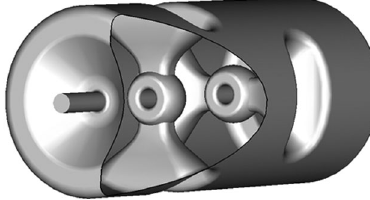
FIG. 21. Design of a ring-shaped aperture we are using to study possible reduction in multipole effects. This design is adapted from [37].